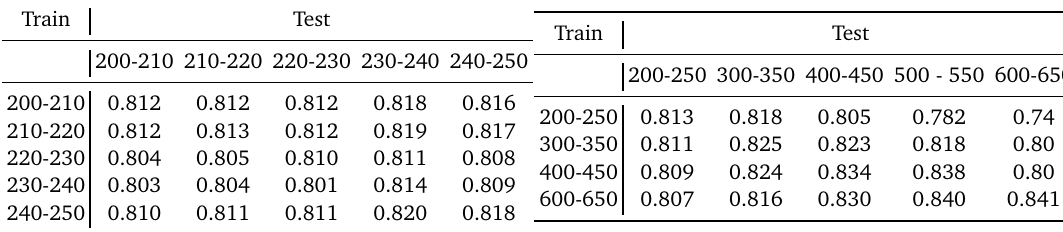
Table 1: Areas under the ROC curve for the L O L A tagger trained and tested on pure samples sliced in p . The uncertainty on each entry is one to two units on the last T , j shown